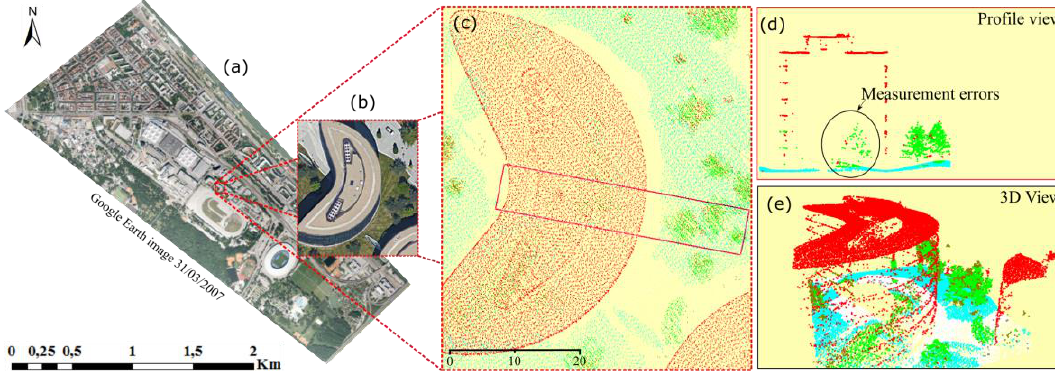
Figure 9. Erroneously measured points inside a mirroring building with a glass façade in the 2015 dataset. ( a ) The Google earth image located the position of the building; ( b ) orthophoto showing the selected area; ( c ) the ground view of the point cloud; ( d ) the profile view displays the erroneously measured point inside the building; and ( e ) 3D view of the point cloud.